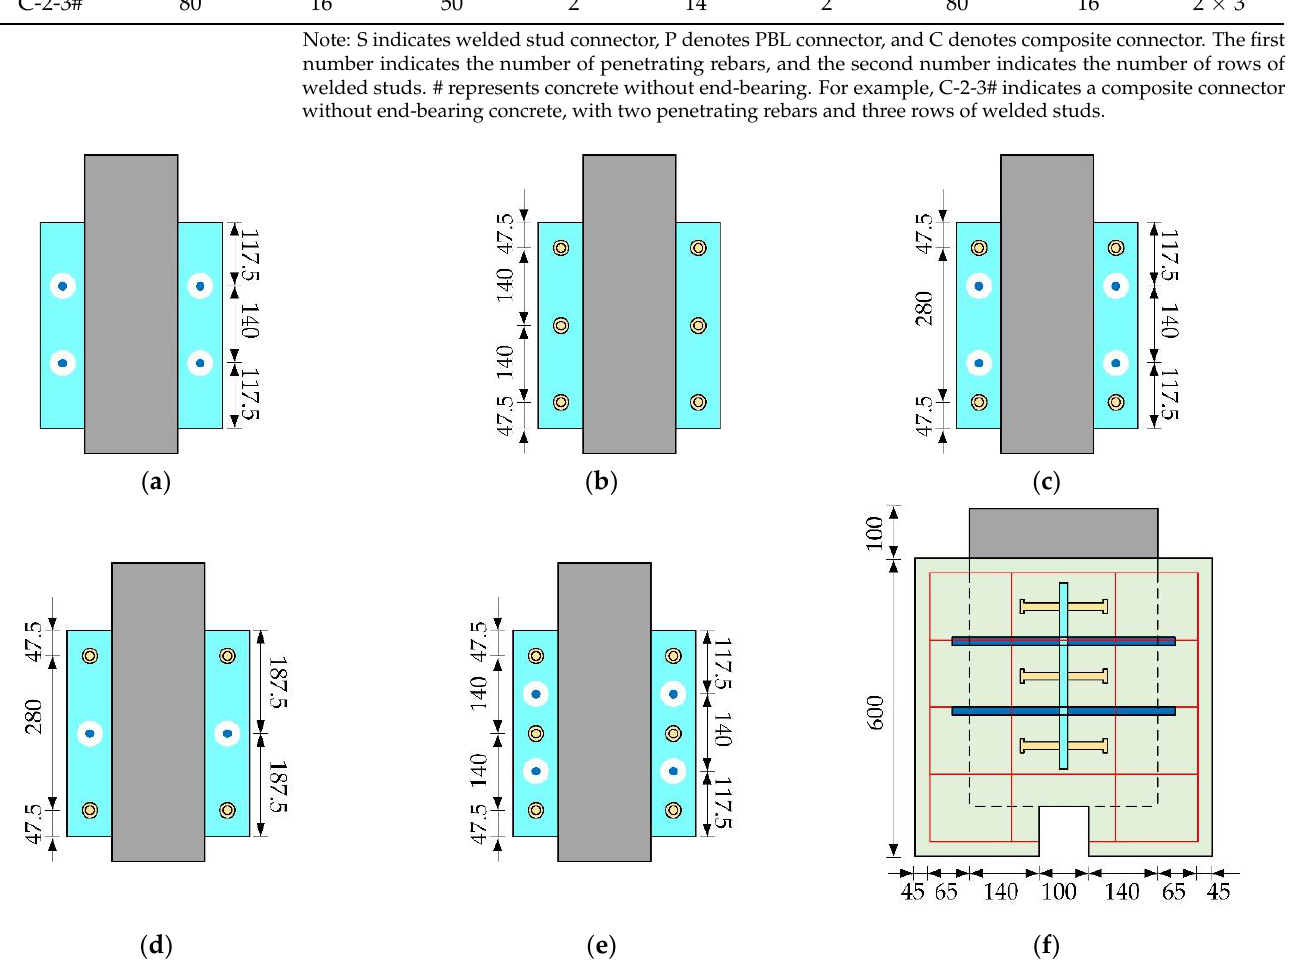
pressive strength and elastic modulus are 35.64 MPa and 34.26 GPa, respectively. Tensile strength tests were performed on steel plates and rebars. The yield strength, ultimate tensile strength and elastic modulus measured by tests are shown in Table